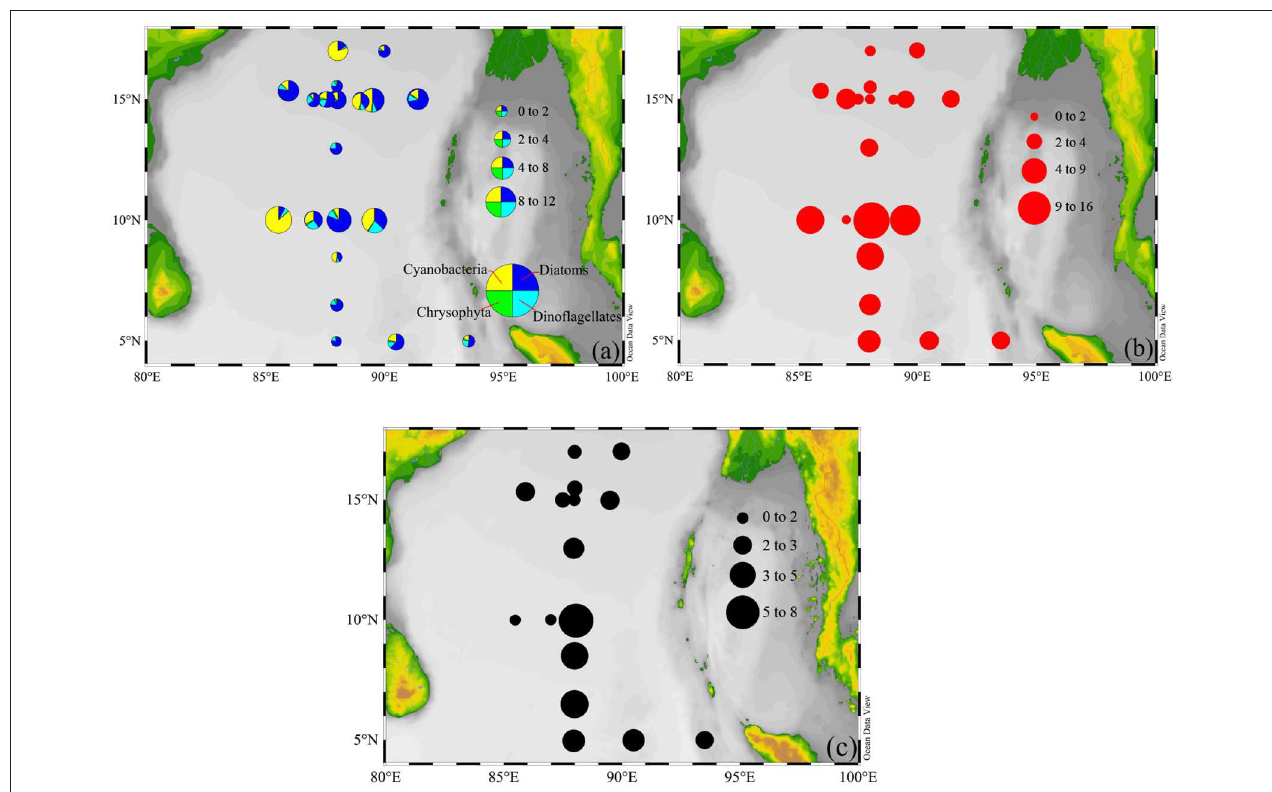
FIGURE 6 | Spatial distributions of (a) phytoplankton abundance ( × 10 4 cells m − 3 ), (b) FRRF- GP Zeu , and (c) 14 C- PP Zeu [mg C (mg chla) − 1 h − 1 m − 2 ] within the upper Z eu depth.